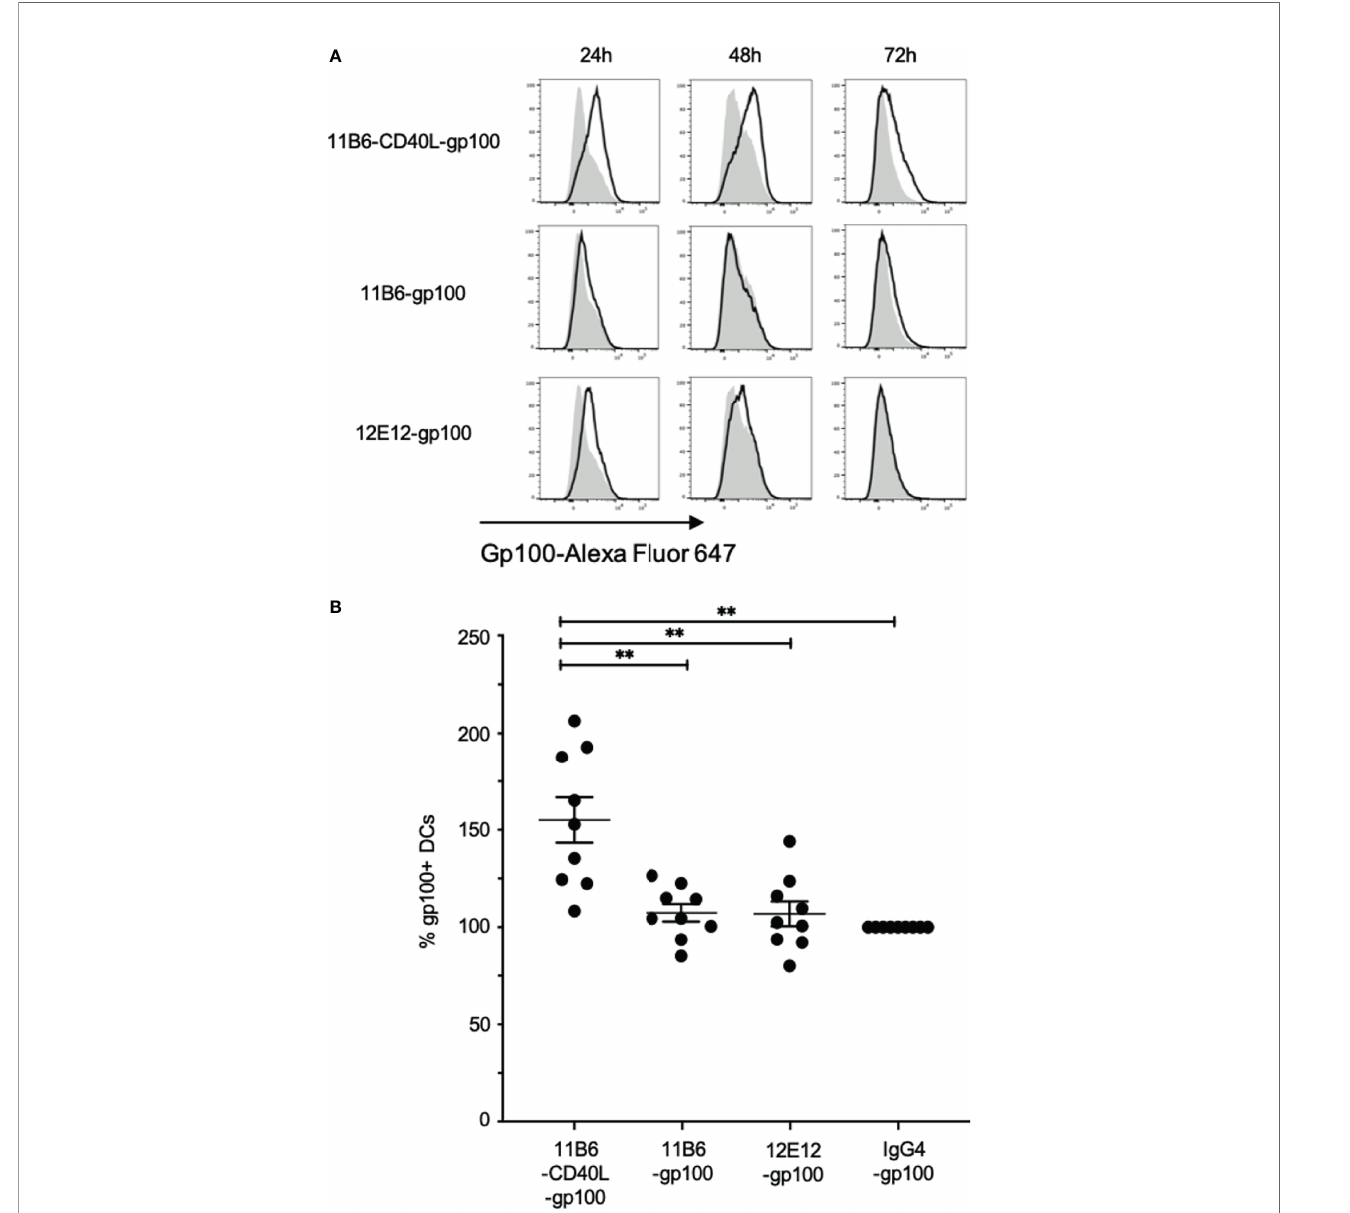
FIGURE 8 | Anti-CD40-CD40L-targeted melanoma gp100 antigen is ef fi ciently presented on MDDC HLA-A2. Normal donor MDDCs were treated with 50 nM anti- CD40 or control hIgG4 antibodies fused to a dominant Class I gp100 peptide. Cultures were harvested at 24, 48, and 72 h and probed with fl uorescently tagged 1A9 mAb to detect surface gp100 peptide/HLA-A2 complex via fl ow cytometry analysis. (A) The panels show frequency versus fl uorescence intensity plots of MDDCs treated with either the indicated anti-CD40-gp100 constructs (black outline), or control hIgG4-gp100 (gray areas). The data are one representative of three independent experiments. (B) Total fl uorescence of each anti-CD40-gp100-treated population was calculated and compared to the hIgG4-gp100-treated cells, which was set at 100%. Averaged over the three experiments and over the three time points anti-CD40 11B6-CD40L-gp100 gave a mean value of 155 ± 35;